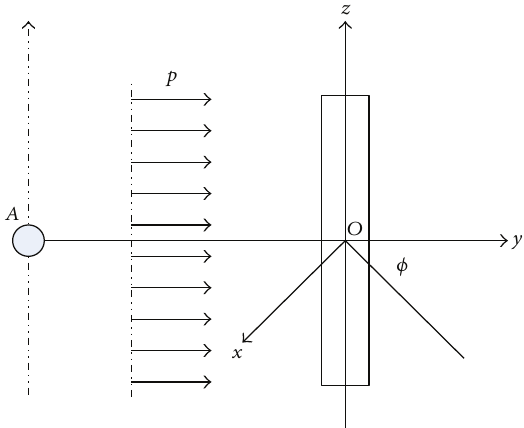
Figure 1: Scattered wave field of cylindrical